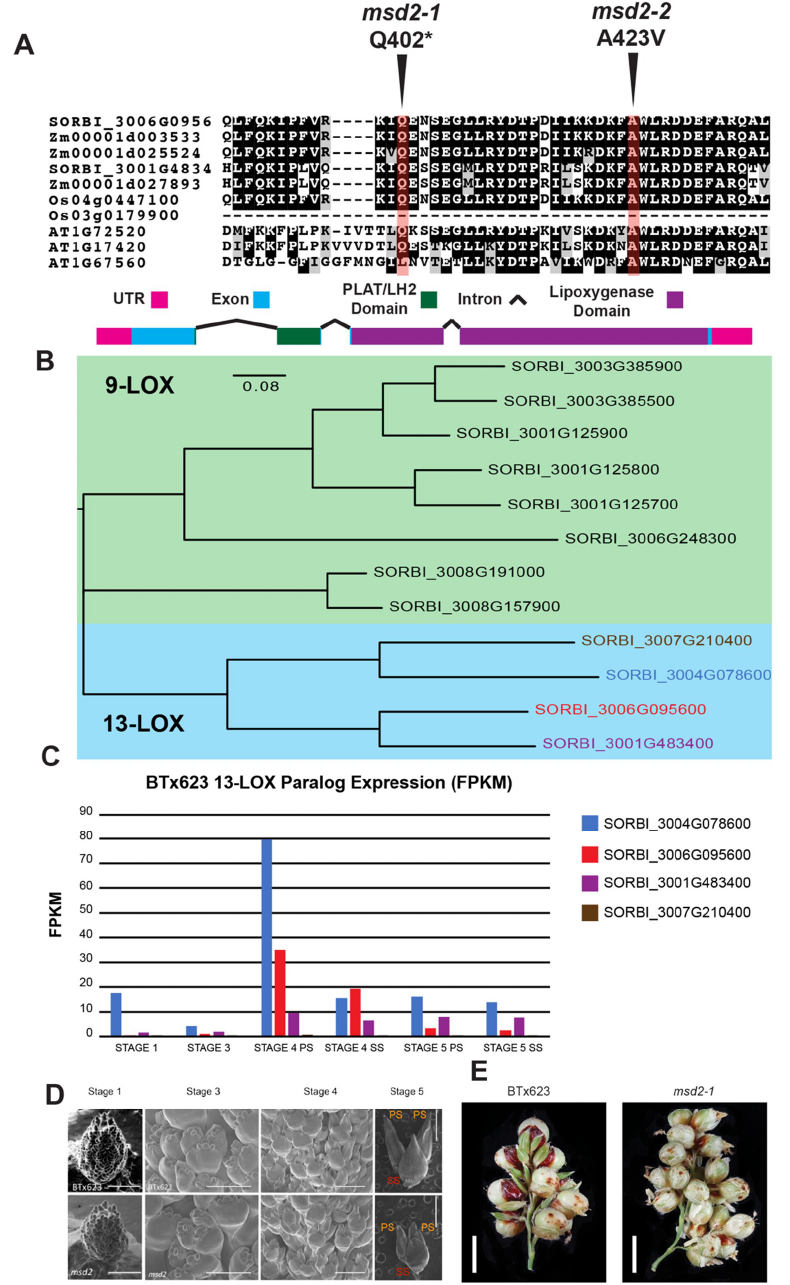
Figure 1. ( A ) Boxshade section of a MUSCLE alignment for MSD2-orthologous sorghum, maize, rice, and Arabdiopsis lipoxygenase (LOX) peptide sequences surrounding the ethyl methane sulfonate (EMS)-induced changes within MSD2. Arrows with red highlights indicate the positions of the msd2-1 (GLN > premature stop) and msd2-2 (Ala > Val) mutations. Below the alignment is a diagram of the MSD2 gene; colored boxes indicate encoded domains of the gene product. The sizes of legend boxes are equivalent to 100 base pairs. ( B ) Phylogenetic tree of sorghum 9- and 13-LOX proteins (MSD2 highlighted in red). ( C ) RNA-seq FPKM expression data of the 13-LOX paralogs across developing panicle tissue stages (colors correspond to panel B ). ( D ) SEM images of developing inflorescence meristems in WT and msd2-1 . Scale bars are 1 mm in length for stages 1, 4, and 5, and 500 µ m for stage 3. Sessile spikelets (SS) are indicated in red and pedicellate spikelets (PS) in orange. ( E ) A section of a secondary branch of late-dough filling panicles from WT and msd2-1 lines. White scale bar indicates a length of 0.5